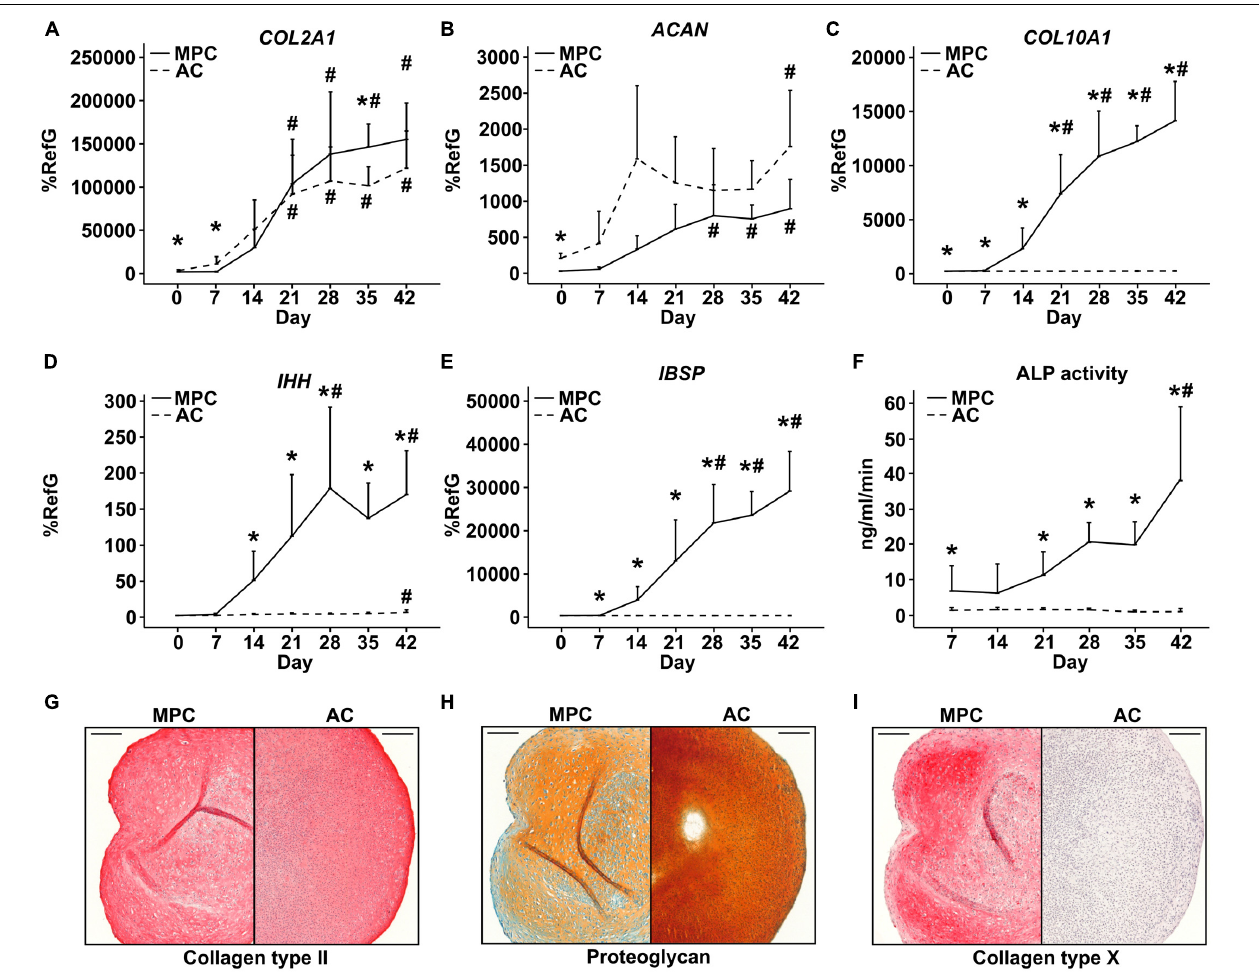
FIGURE 2 | Characterization of MPC and AC differentiation. MPC and AC pellets were subjected to chondrogenic induction for 6 weeks. Samples harvested in weekly intervals were subjected to gene expression analysis by qPCR for indicated genes (A–E) , and levels were referred to reference genes HNRPH1 and CPSF6 ( n = 4 donors). (F) Alkaline phosphatase (ALP) activity was determined in culture supernatants pooled from five pellets ( n = 4 donors). Data are shown as mean ± standard deviation over the time course of 6 weeks. MPC versus AC; Mann–Whitney U test; *, p ≤ 0.05 versus d0 (d7 ALP activity) ANOVA Tukey; #, p ≤ 0.05. (G–I) : Paraffin sections of AC and MPC pellets at day 42 were stained for (G) collagen type II and (I) collagen type X by immunohistochemistry or with (H) Safranin O/Fast Green to visualize proteoglycan deposition. Scale bars represent 200 µ